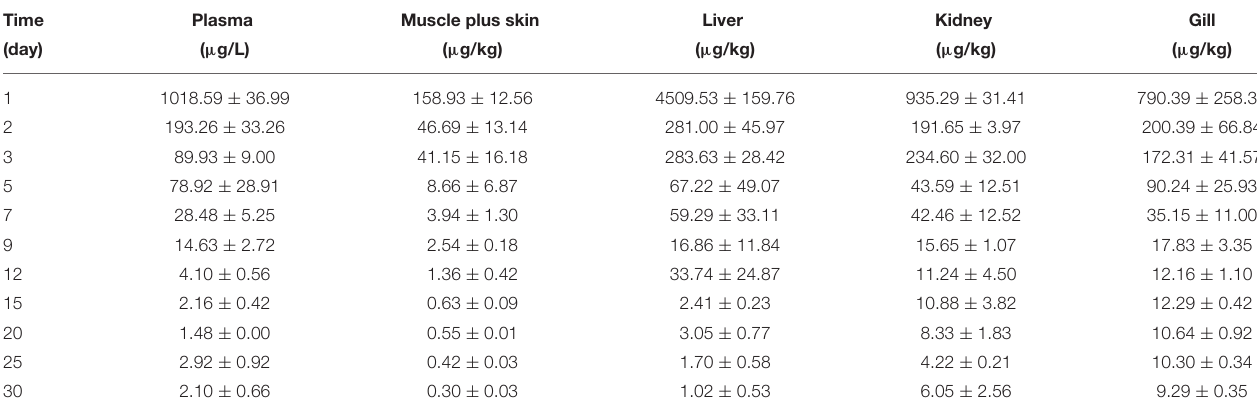
TABLE 3B | The tiamulin concentrations in plasma and tissues of Nile tilapia after daily oral administration of a single dose of 20 mg/kg for 5 days at 25 ◦ C ( n = 6). Time Plasma Muscle plus skin Liver Kidney Gill